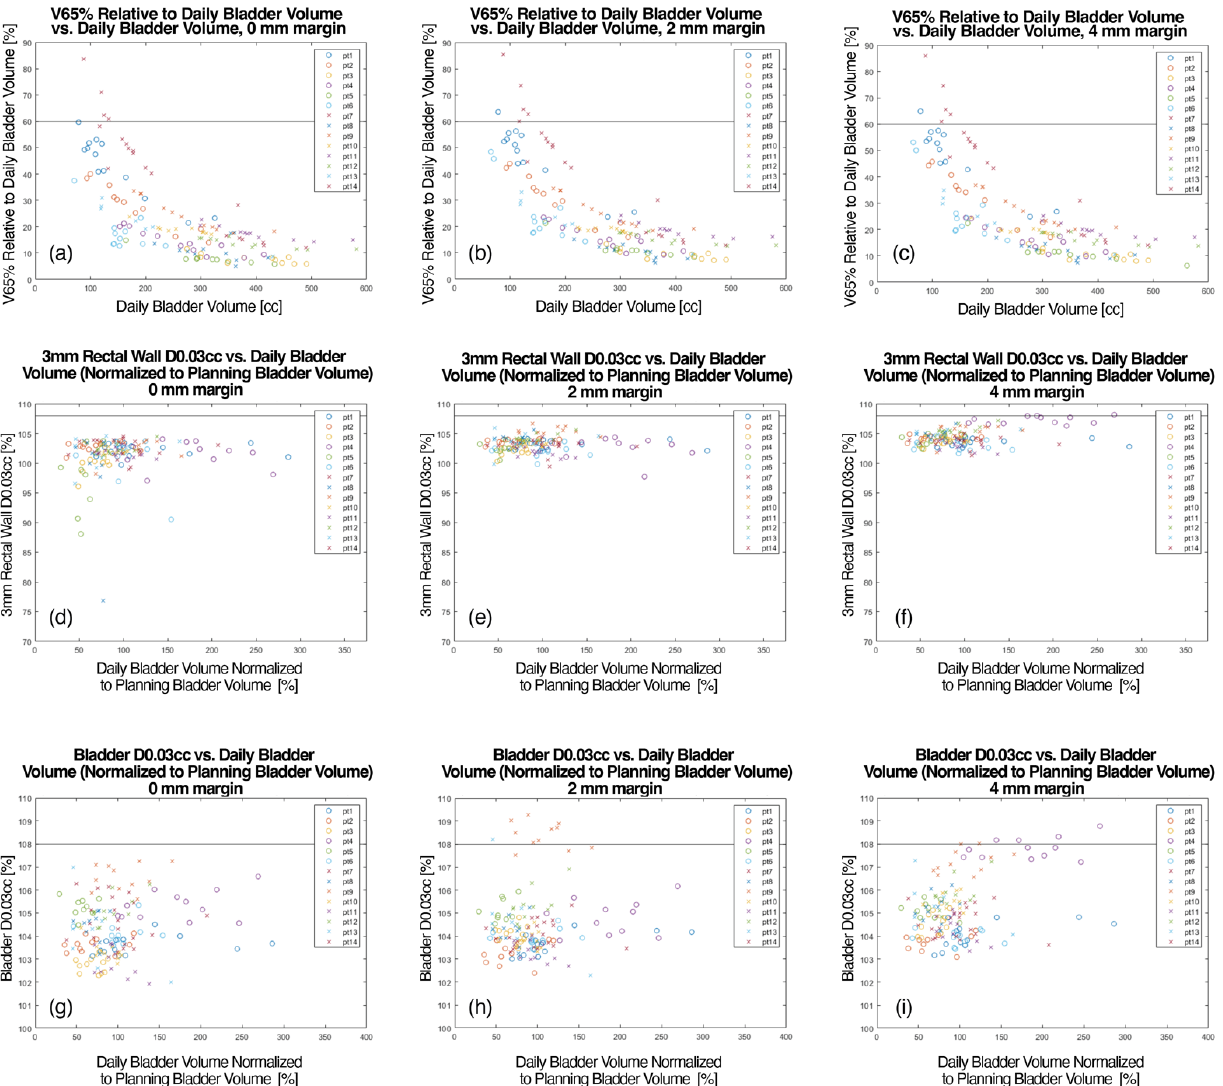
Figure 3. ( a – c ) Daily bladder volume that passed the V65% < 60% constraint versus daily bladder volume for different PTV margins (0-, 2-, and 4 mm). ( d – f ) Maximum rectal wall (3 mm) dose as a function of daily bladder volume for various target margins. ( g – i ) Maximum bladder dose (0.03 mL) versus daily bladder volume for different PTV margins (0-, 2-, and 4 mm). Rectum DVH parameters (V40Gy, V65Gy, V70Gy, and V75Gy) are demonstrated in